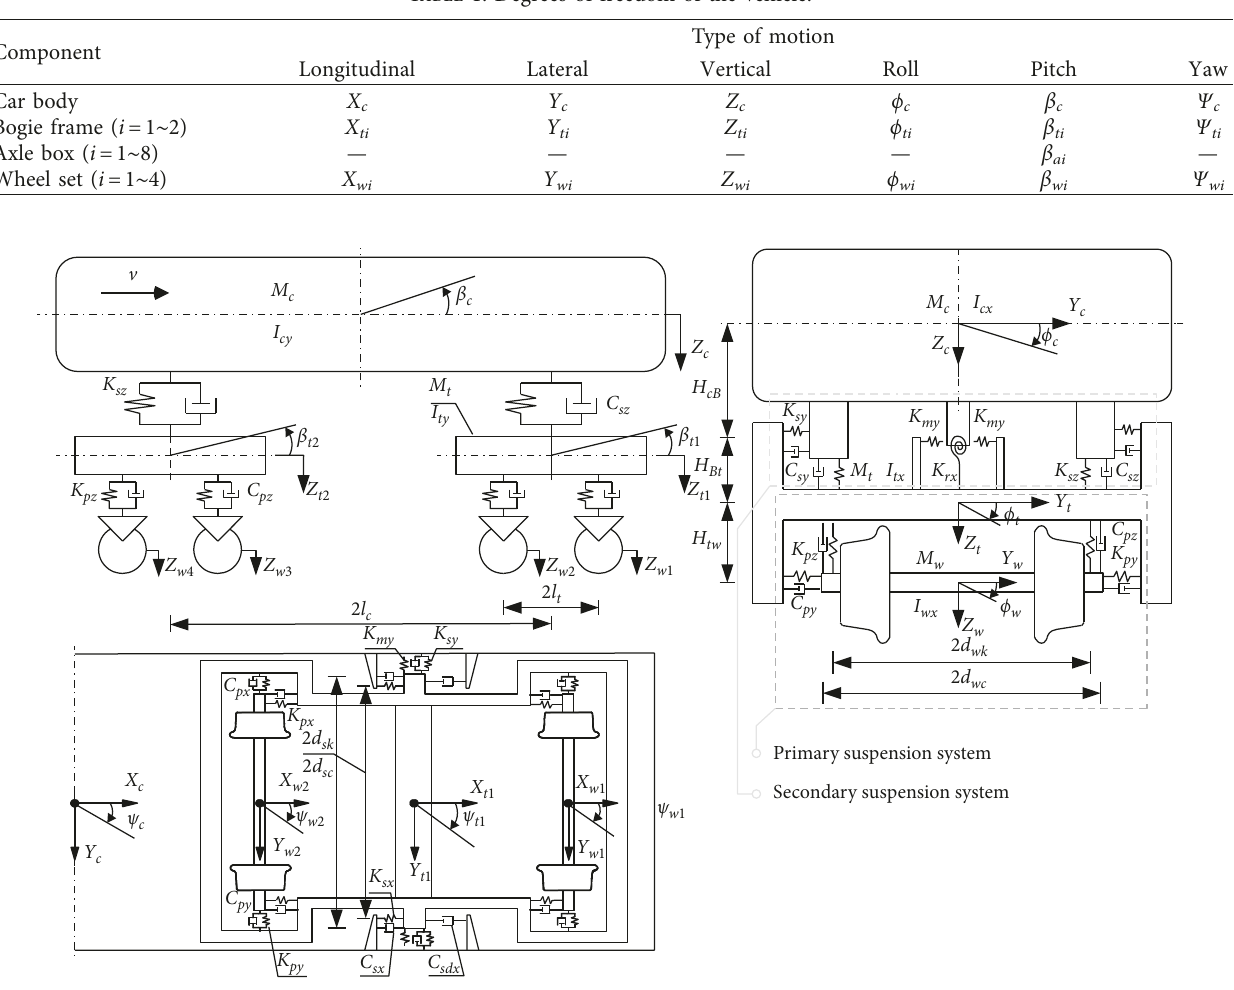
Figure 3: A schematic diagram of the vehicle